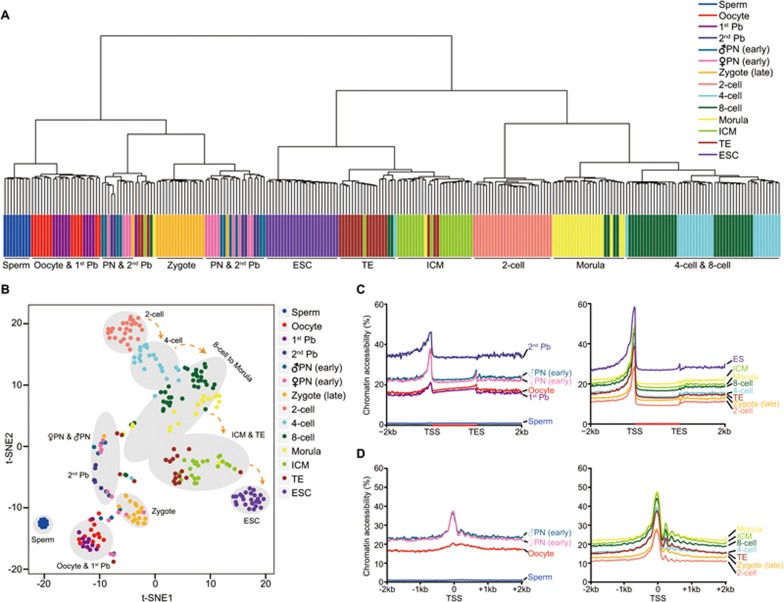
Chromatin accessibility dynamics of mouse preimplantation embryos revealed by single-cell COOL-seq analysis. (A) Unsupervised hierarchical clustering of mouse preimplantation embryos based on the averaged GCH methylation level of proximal NDRs (58 677 proximal NDRs) detected in all of the preimplantation stages. (B) t-SNE (t-Distributed Stochastic Neighbor Embedding) analysis of mouse preimplantation embryos based on the averaged GCH methylation level of proximal NDRs detected in all the stages. (C) The chromatin accessibility along the gene bodies, 2 kb upstream of the TSS and 2 kb downstream of the TES of all the RefSeq genes across different developmental stages. (D) The chromatin accessibility around TSS across all the preimplantation stages. See the legend for Figure 1B for more information.